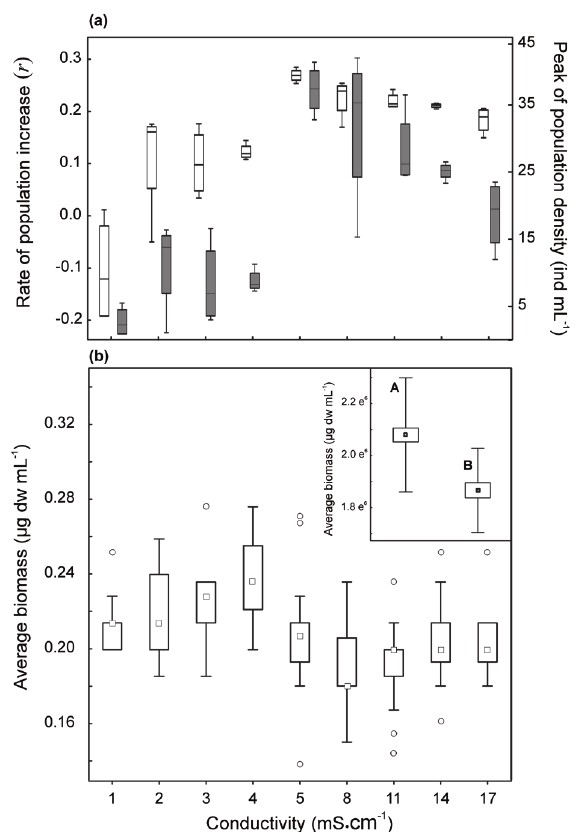
Figure 2 - ( a ) Box plots of the rate of population increase of Brachionus plicatilis at the peak of population growth (day 12) in all the conductivity treatments (white boxes) and the peak of population density (grey boxes). ( b ) Box plots of the average biomass of Brachionus plicatilis amictic females at each conductivity level by the end of the experiment. The inset indicates the differences between ( A ) nonovigerous and ( B ) ovigerous females. Figure indications relative to the median value: box, 25% –75%; whiskers, maximum and minimum values within 95% of the distribution; and points,